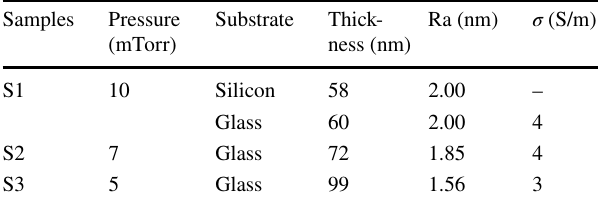
Fig. 4 SEM high and low magnification images of SnO 2 film deposited on silicon substrate ( a and b ) at 10 mTorr, and glass substrate ( c , d ), ( g , h ), and ( e , f ) at 10 and 7 and 5 mTorr working pressure, respectively Table 2 Measured average film thickness, average surface roughness (Ra), and electrical conductivity (σ) at different sputter pressure (5, 7, 10 mTorr)